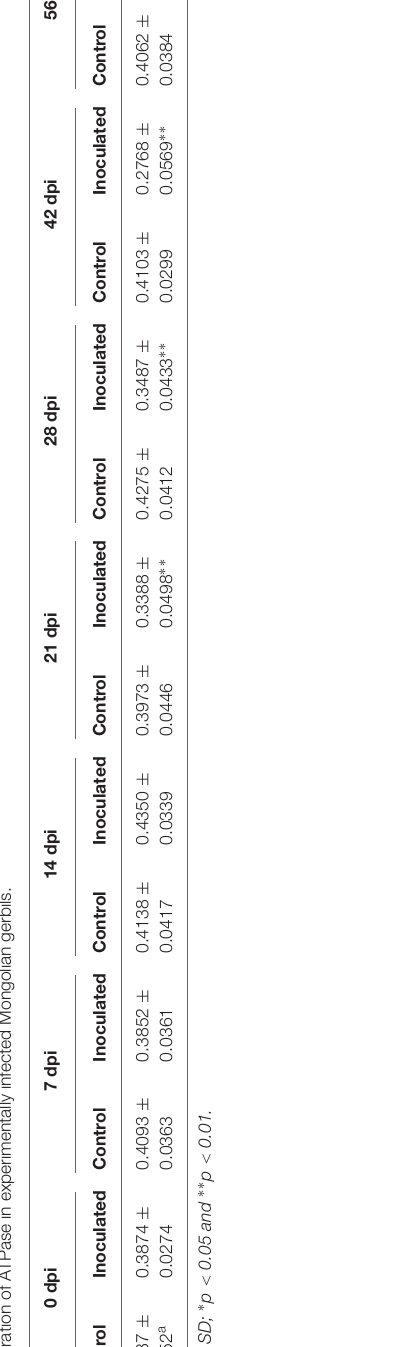
As presented in Figures 4A,B , the number of TUNEL-positive hepatocytes (/mm 2 ) was significantly increased in the